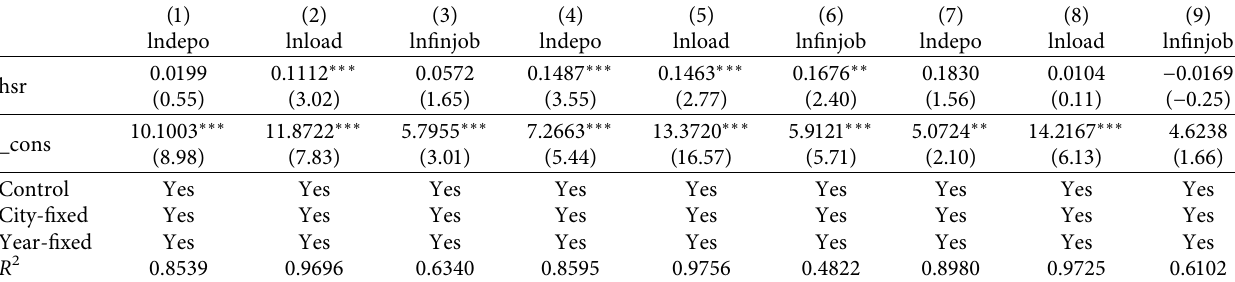
Table 4: Heterogeneity